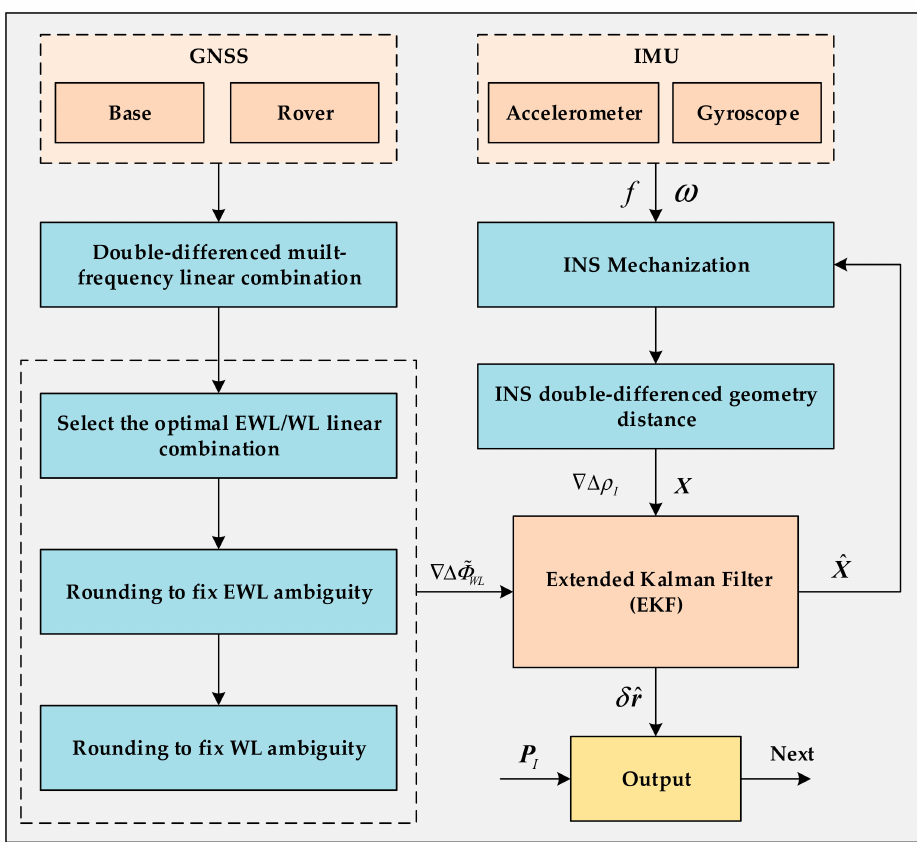
Figure 1. The flow chart of the multi-frequency GNSS/INS tightly coupled positioning